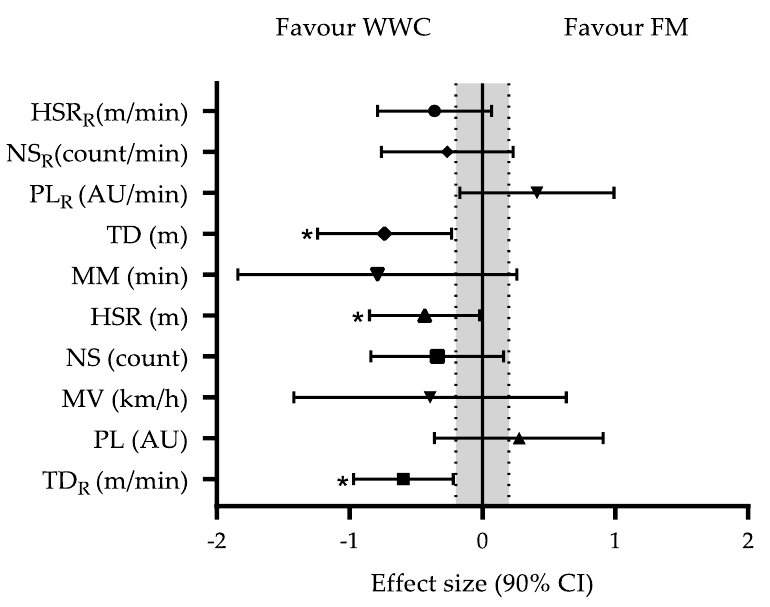
Figure 4. Standardized difference of external load between periods. FM friendly match; WWC Women world cup; MM match minutes; TD total distance; HSR high speed running; NS number of sprint; MV maximum velocity; PL player load; R relative to the minutes of the match; AU arbitrary unit; * p <